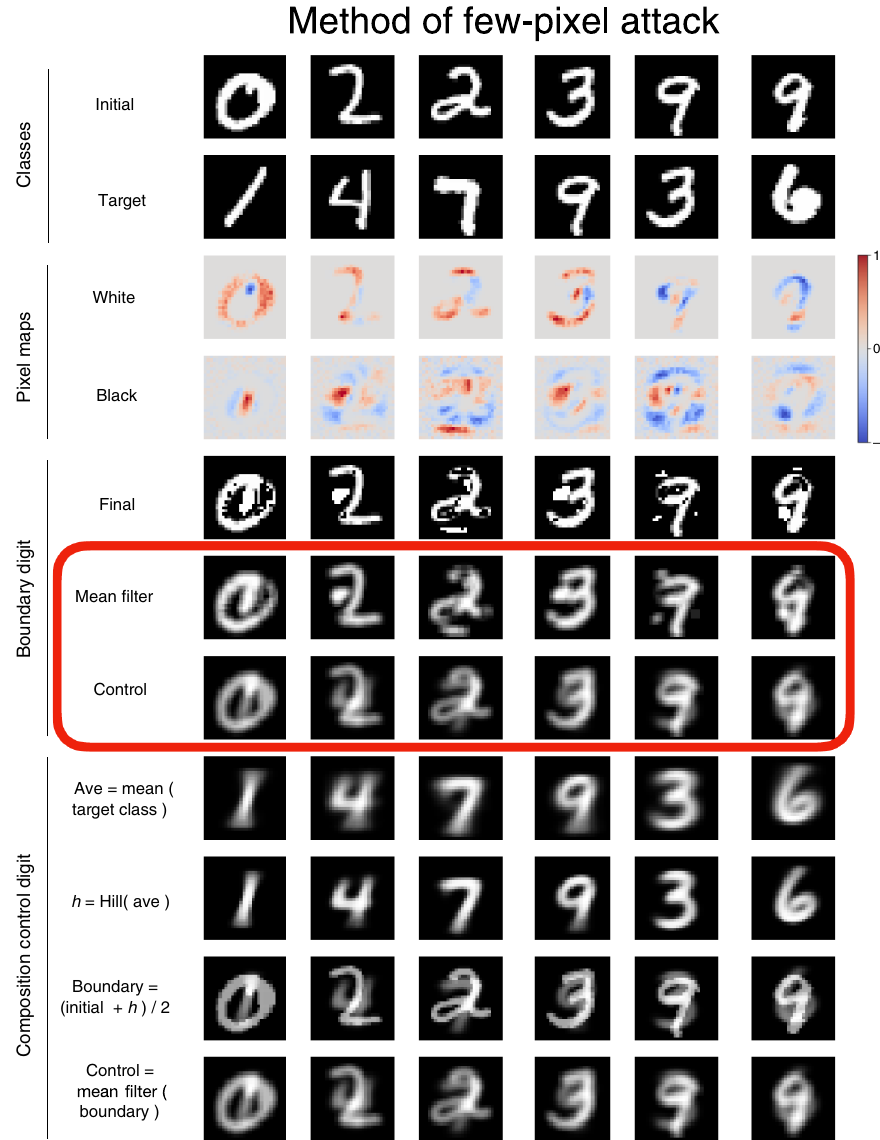
FIG. 7. Method of few-pixel attack. Each column shows how a few-pixel attack causes misclassification of an initial digit to a target class. The important result is the prefiltered boundary digits and the control in the red rectangle. Pixel maps determine which pixels increase (red) or decrease (blue) the score when turning an individual pixel in the initial digit white or black. We merge the pixel maps, sort this list of pixels, and go through it from maximum to minimum change in score until misclassification occurs, resulting in the prefiltered digit. We apply a mean filter to make them look more like real digits, and indeed, these mean-filtered boundary digits closely resemble our control digits at the boundary. The control digits are composed of the mean-filtered initial digit plus locally contrasted [with hill function ( N ¼ 3 ; θ ¼ 0 . 5 )] average digit of the target we compare the mean-filtered digit at the decision boundary to the control: The sum of the initial digit and the hill function of Eq. (8) ( N ¼ 3 ; θ ¼ 0 . 5 ) on the average of all digits in the target class, then mean filter (Fig. 7 for a step-by-step composition). We apply the mean filter to the control to again remove the artificiality of a digit plus an average and make the comparison between boundary digit and control digit fairer. The similarity between the mean-filtered boundary digit and